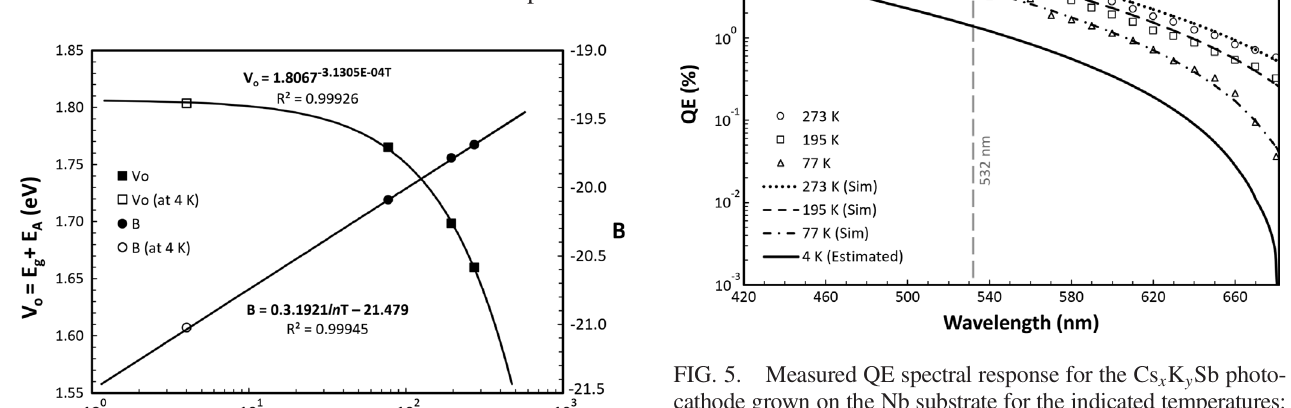
K Sb photo- x y and fit o